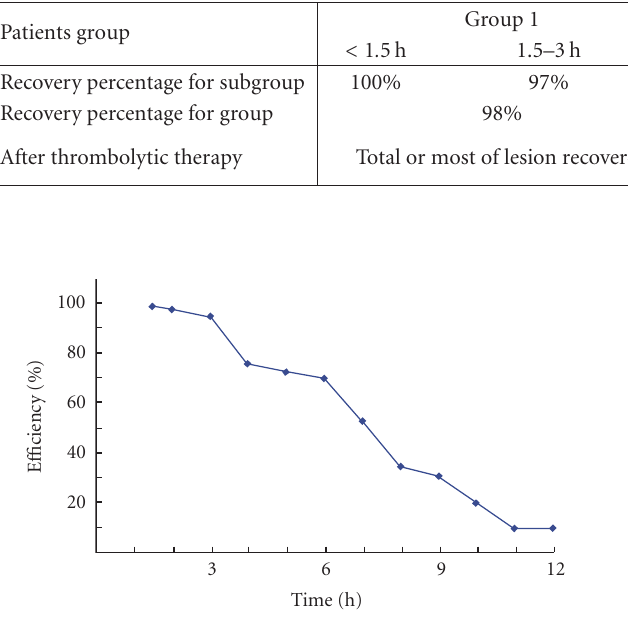
Figure 6: Relationship between therapeutic e ffi cacy and the onset time. The result shows that the earlier the treatment is taken, the better the therapeutic e ffi cacy is. The patient can totally recover if he was treated within 1.5 hour from stroke onset. As time goes by, the patient has less chance to recover.